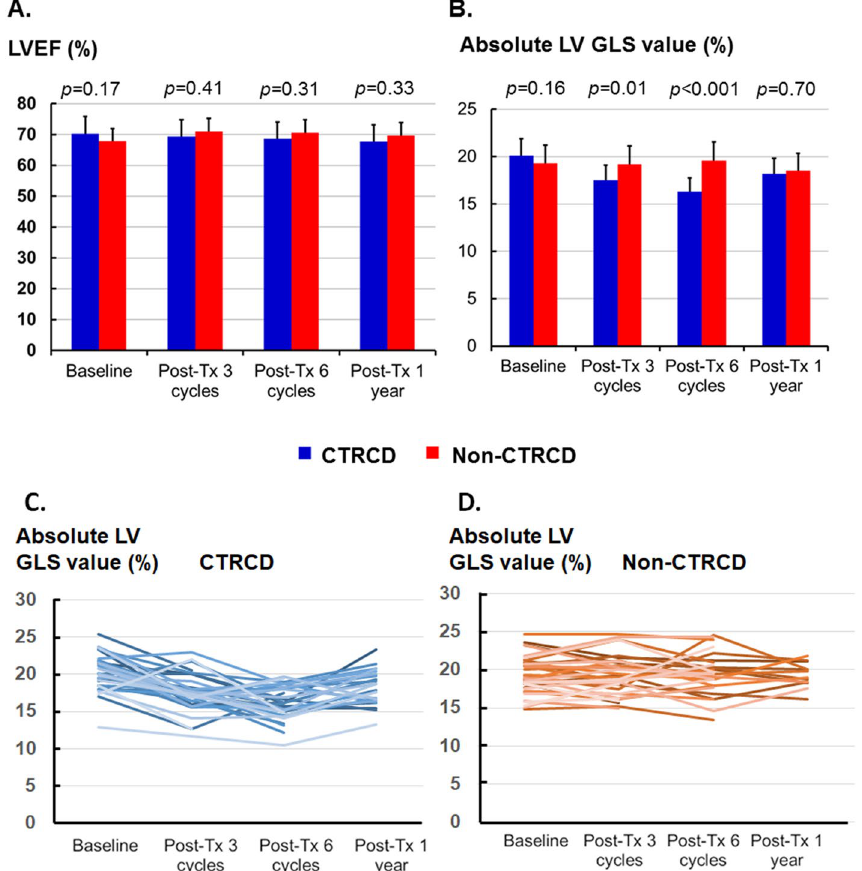
Figure 1. Time trend of LV EF and GLS. ( A ) There is no change in EF. ( B ) In patients with subtle LV dysfunction, the absolute GLS value was significantly decreased after 3 cycles ( p = 0.01) and 6 cycles of ( p = 0.001) anticancer therapy and partially recovered 1 year later. ( C , D ) Line graph of absolute GLS value (%) changes in patients with CTRCD ( C ) and without CTRCD ( D ).